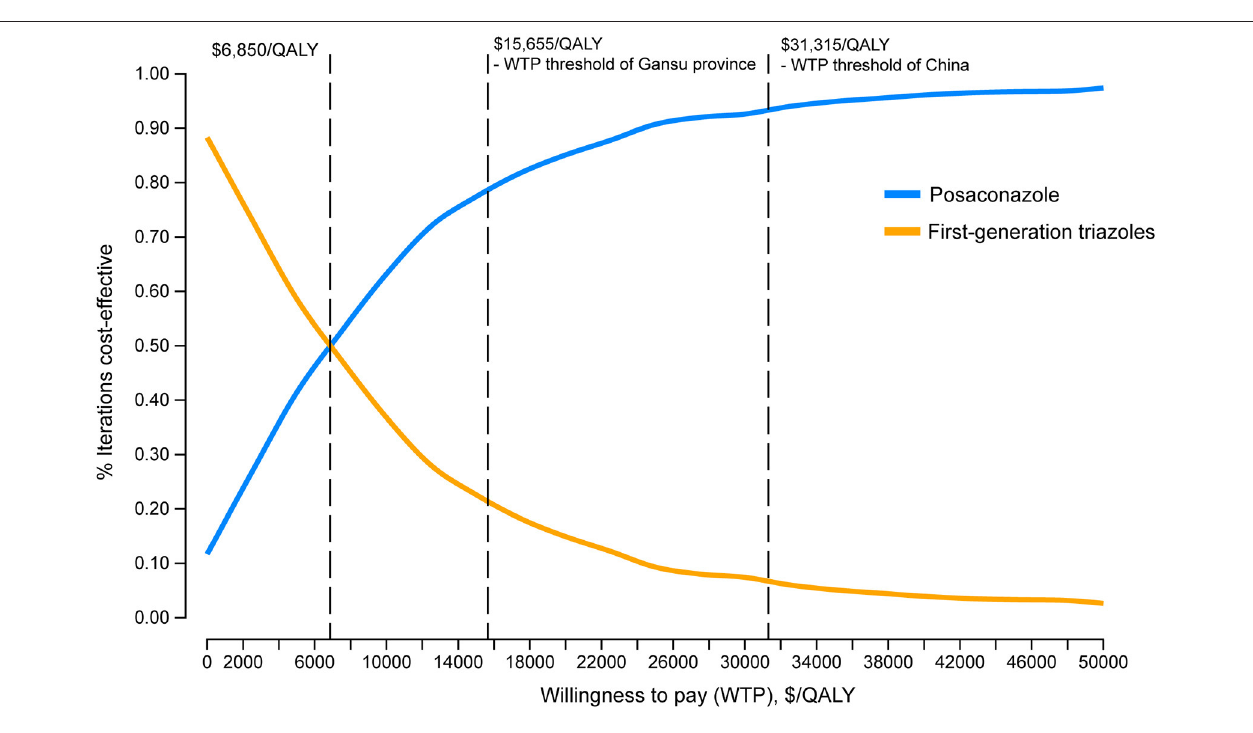
FIGURE 4 | Cost-effectiveness acceptability